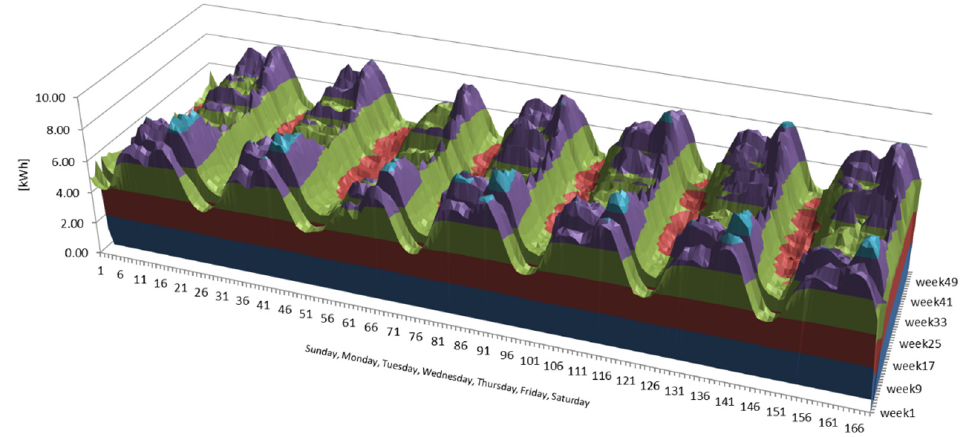
Figure 2. Weekly load curve in 2020 for urban consumers.